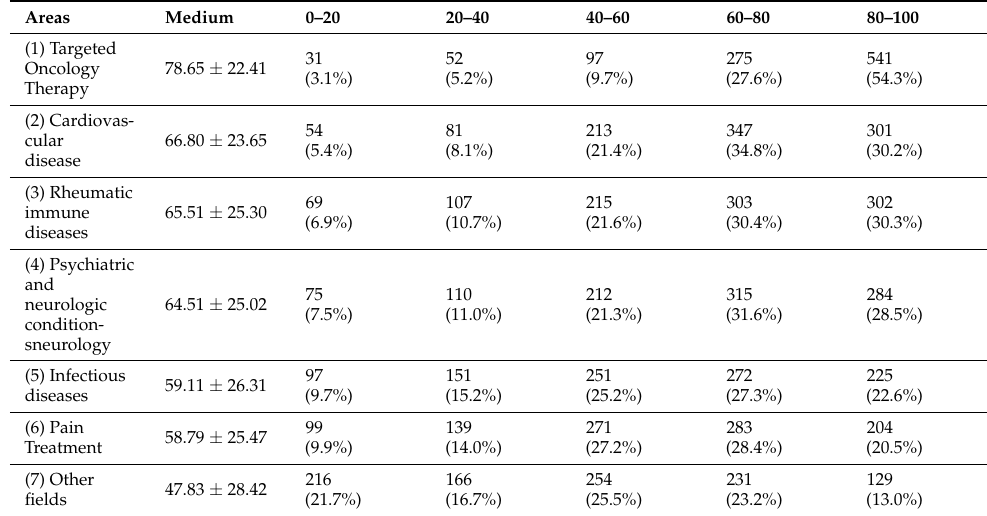
Table 2. Value of pharmacogenomic testing in different treatment areas (scale 0–100).